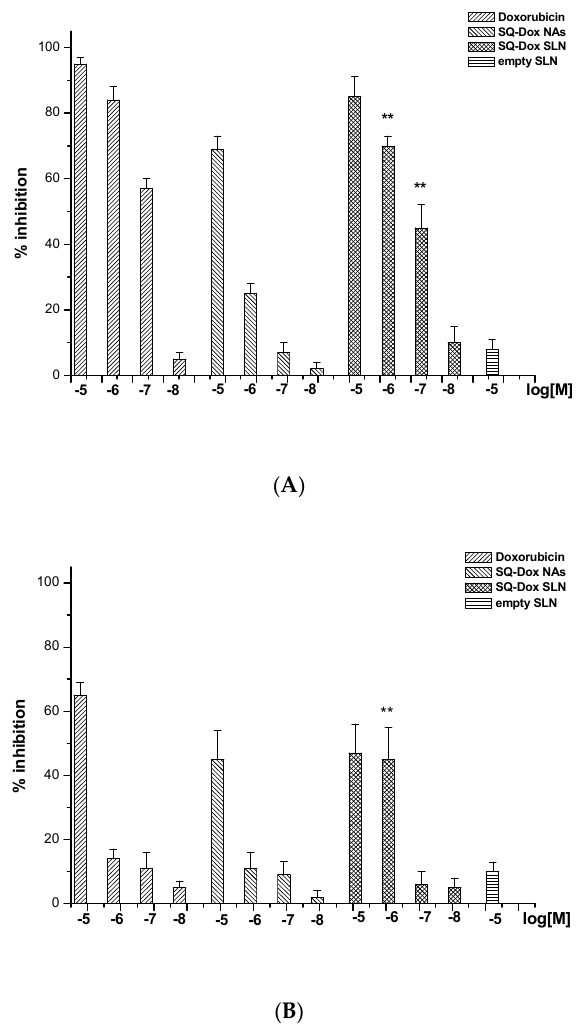
Figure 3. Inhibition of A2780 ( A ) and A2780 res (resistant) ( B ) cell proliferation following Dox, SQ-Dox NAs and SQ-Dox SLN1 treatment. Cells were treated with increasing concentrations (expressed as Dox equivalent) of compounds and empty SLNs for 72 h. Six replicates were used to determine each data point, and five different experiments were performed. One-way ANOVA and Dunnett’s test revealed statistically-significance differences (** p < 0.01) between the effects caused to A2780 res cells of the loaded SLNs vs. SQ-Dox treatments.